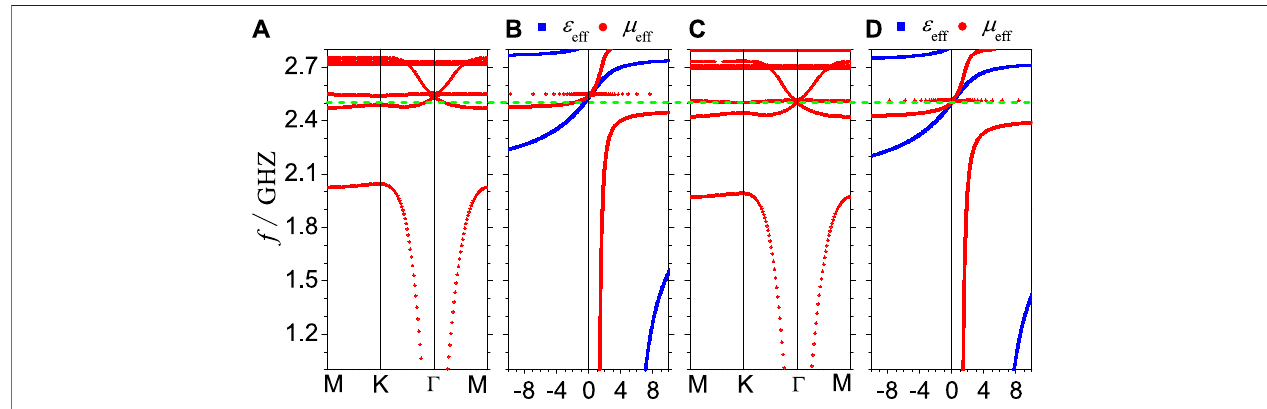
FIGURE2| Photonicbanddiagrams (A,C) aswellasthe corresponding effectivepermittivities ε eff and permeabilities μ eff (B,D) for thetriangular lattice ofMMs with the same lattice separation a = 15 mm but different ferrite rod radii r = 3.64 mm (A,B) and 3.82 mm (C,D) , respectively. The BMF is the same for two MMs with the magnitude H 0 = 500 Oe. The green dashed line marks the operating frequency f = 2.5 GHz, which is fi xed unchanged for all the HSMMs.